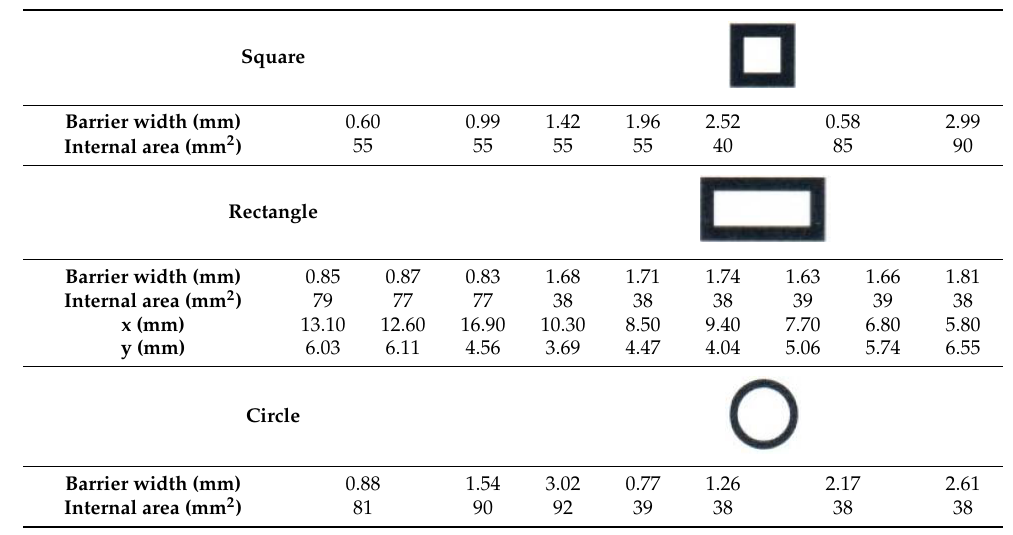
Table 2. Designspecifications of the µPADs. Square